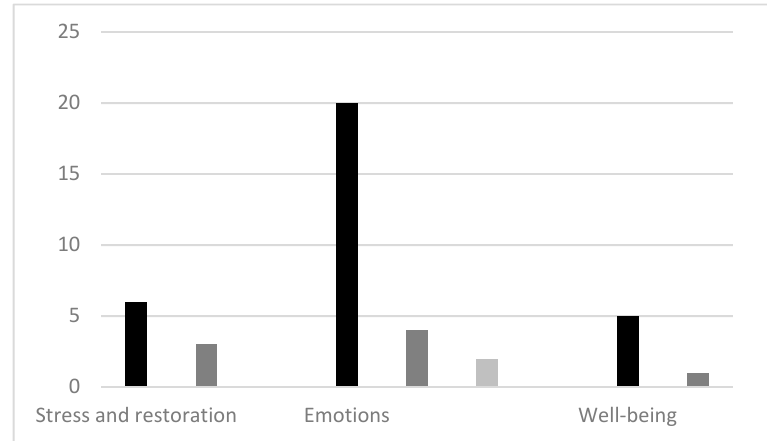
Figure 2. Synthesis of psychological outcomes of nature-based interventions.